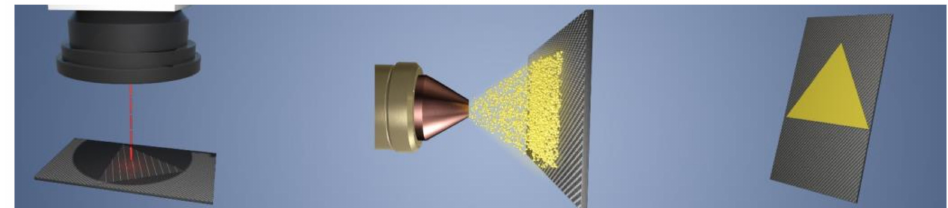
Figure 1. Process chain for metallization of laser-structured FRP, © Fraunhofer